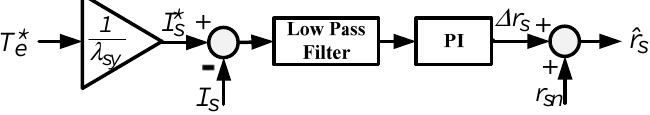
Figure 3. PI resistance estimator.